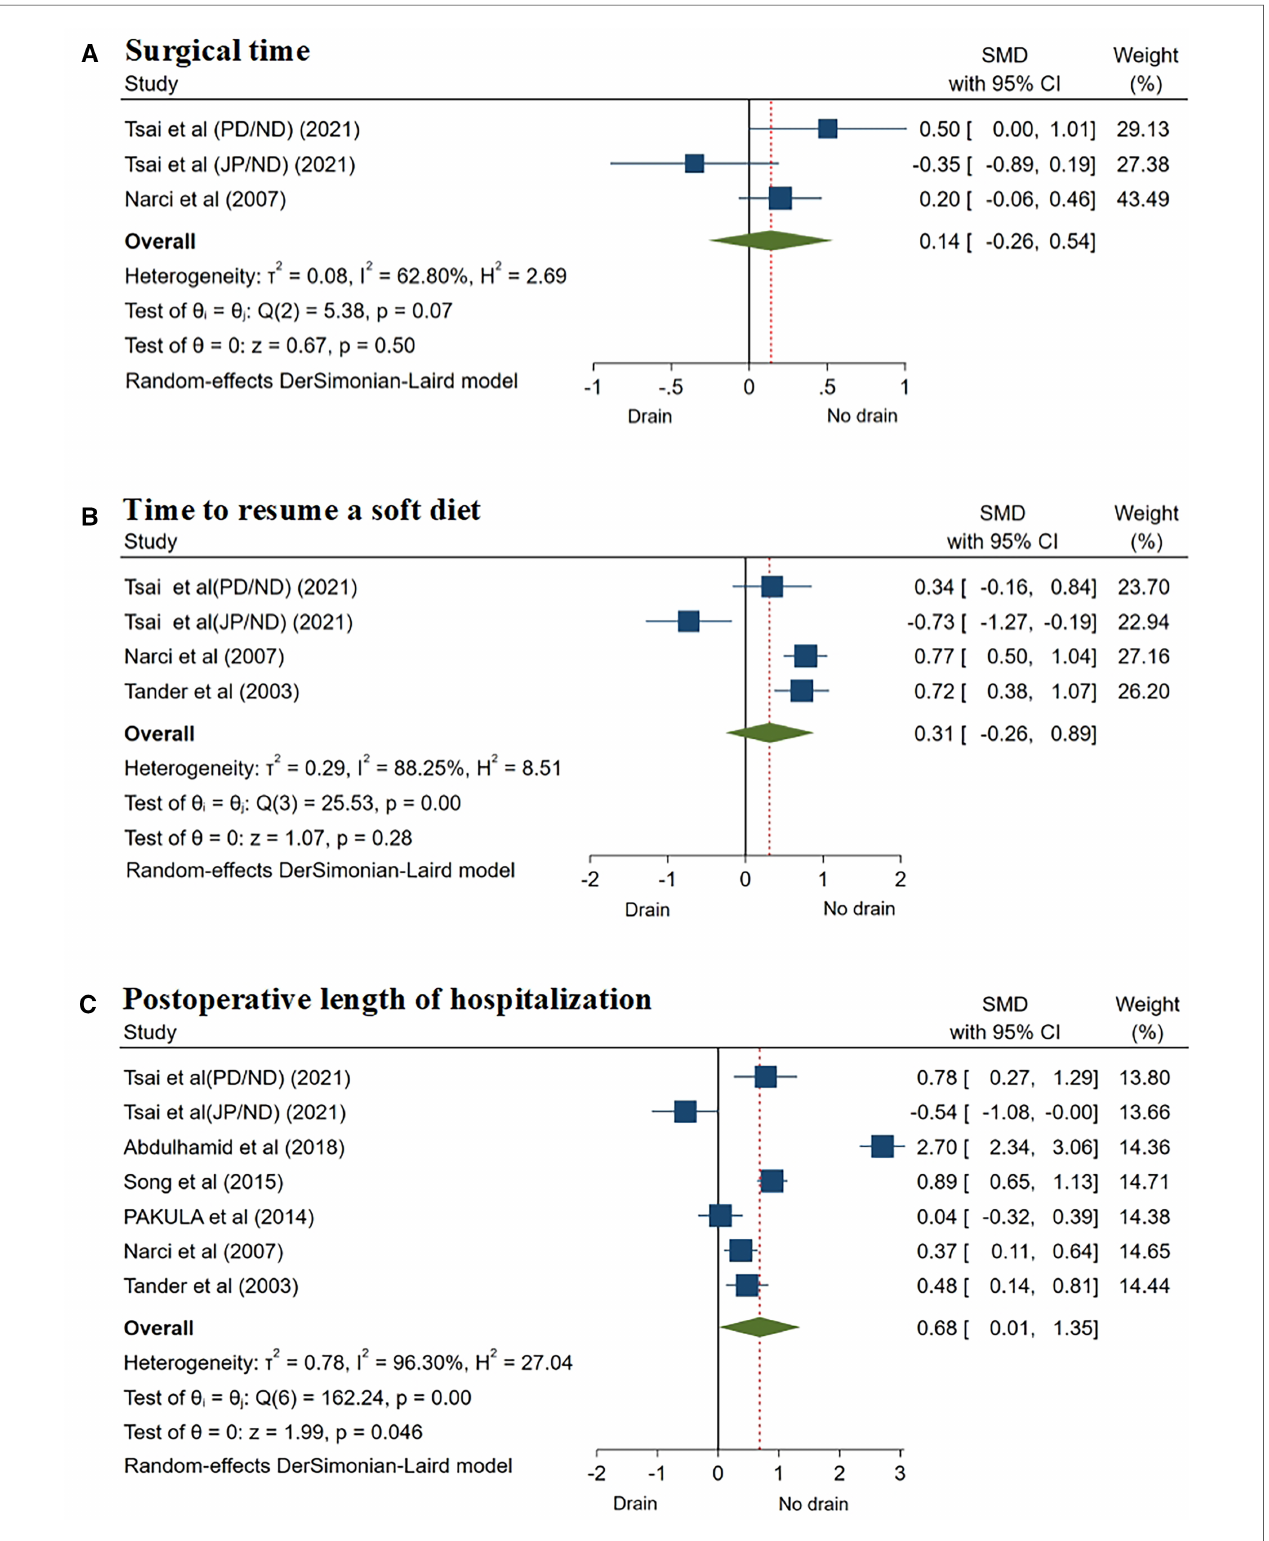
FIGURE 3 Forest plots of meta-analysis and subgroup meta-analysis comparing surgical feature and postoperative recovery, ( A ) surgical time; ( B ) time to resume a soft diet; ( C ) postoperative length of